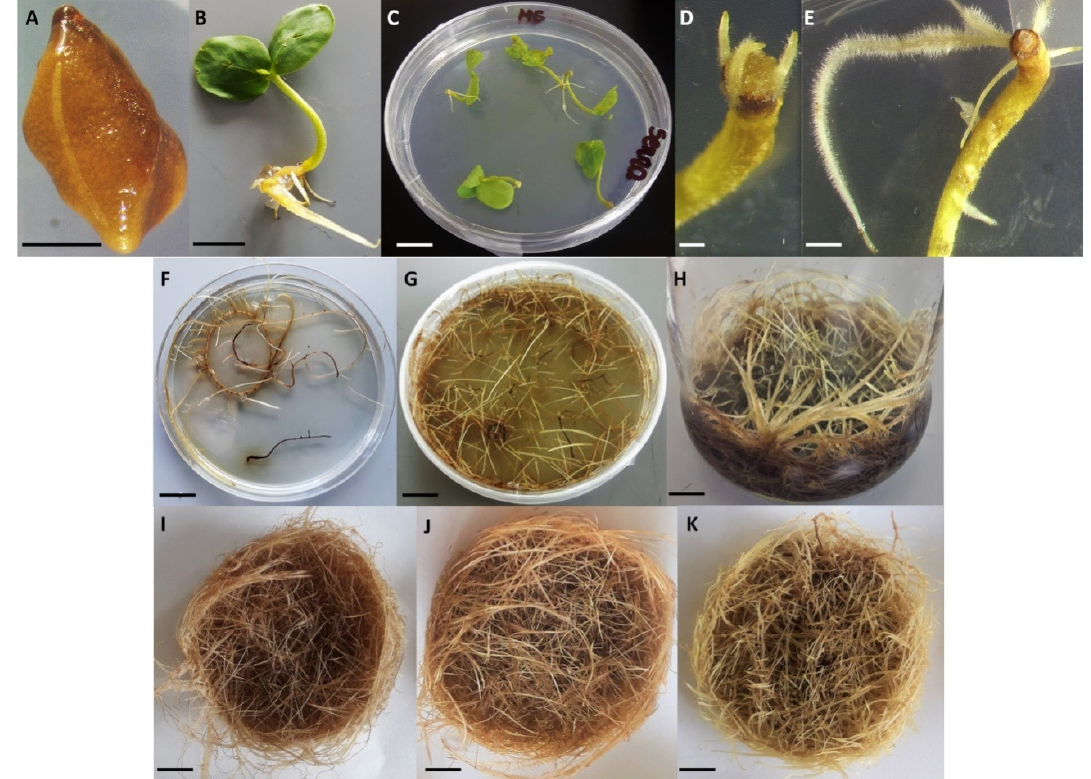
Figure 2. Subsequent stages of obtaining transgenic S. obtusifolia in vitro hairy root cultures. ( A )- S. obtusifolia seed, ( B )- S. obtusifolia 14 day old seedling used for genetic transformation, ( C – E )-SOPSS hairy roots formation on S. obtusifolia seedlings after Agrobacterium transformation, ( F )- SOPSS hairy roots after 7 days on Murashige and Skoog (MS) selection medium, ( G )- SOPSS hairy roots after 14 days on MS solid medium, ( H )- SOPSS hairy roots after 21 days on MS liquid medium I-K SOA4 ( I ), SOPSS ( J ), SOGFP ( K ) hairy roots after 14 days of culture on MS liquid medium used for biological studies, bar = A-2 mm, B-1 cm, C-1 cm, D-2 mm, E-5 mm, F-K-1 cm.